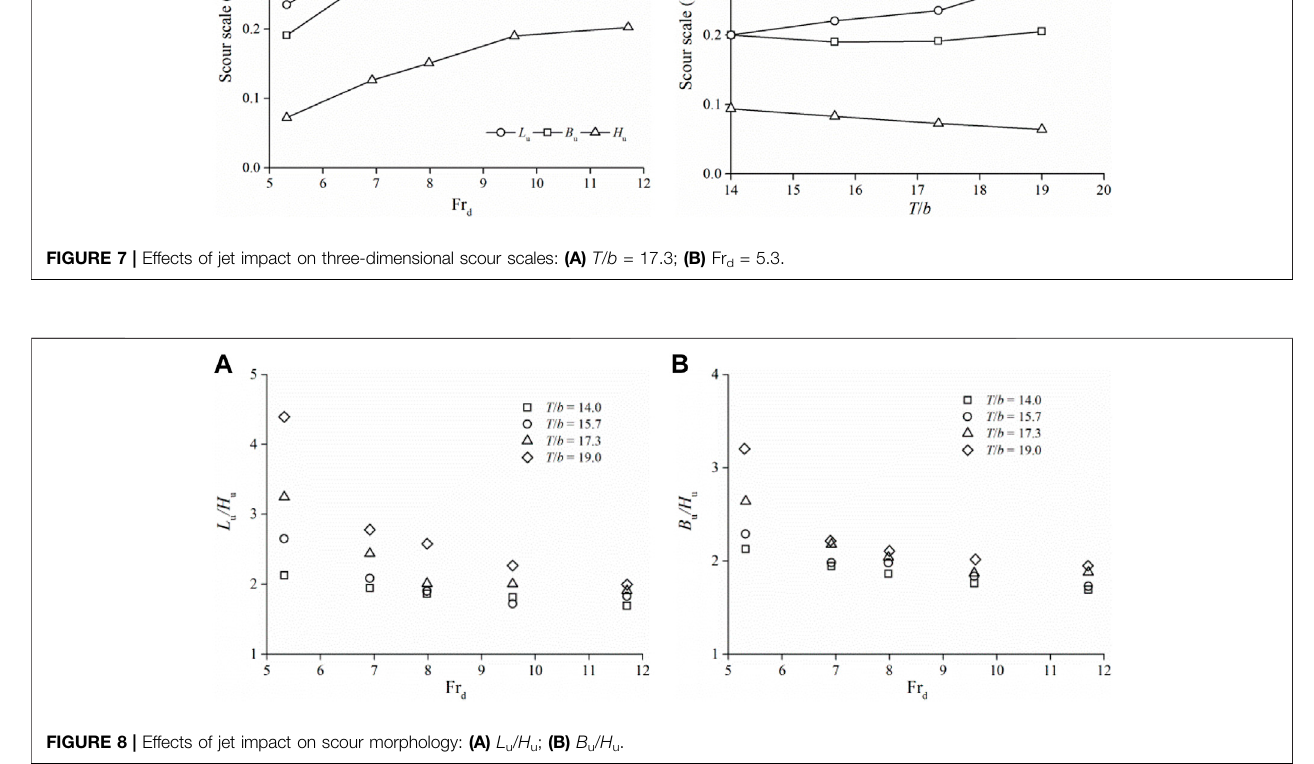
FIGURE 8 | Effects of jet impact on scour morphology: (A) L u / H u ; (B) B u / H u .